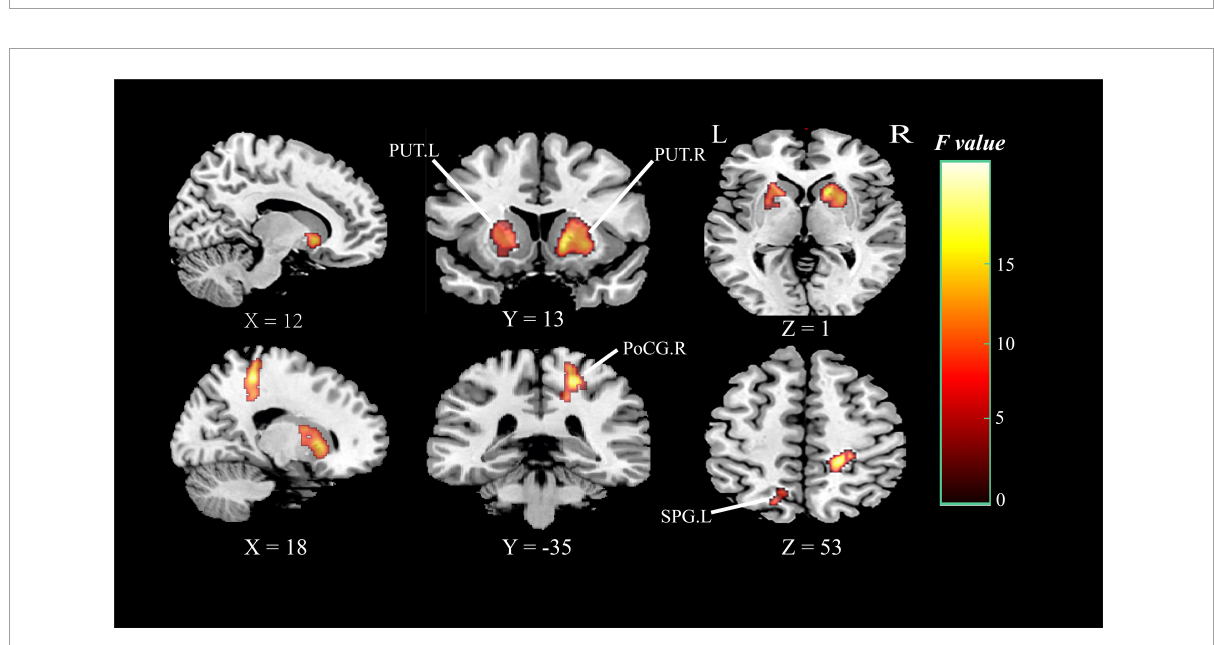
FIGURE4 Brain regions of group differences in CBF values controlling for age gender and education (clusterlevel P < 0.05, FDR corrected, cluster-forming threshold at voxel-level P < 0.001); x, y, z, coordinates of primary peak locations in MNI space; the color bar represents the F values. PoCG, postcentral gyrus; SPG, superior parietal gyrus; PUT, putamen; L, left; R, right.